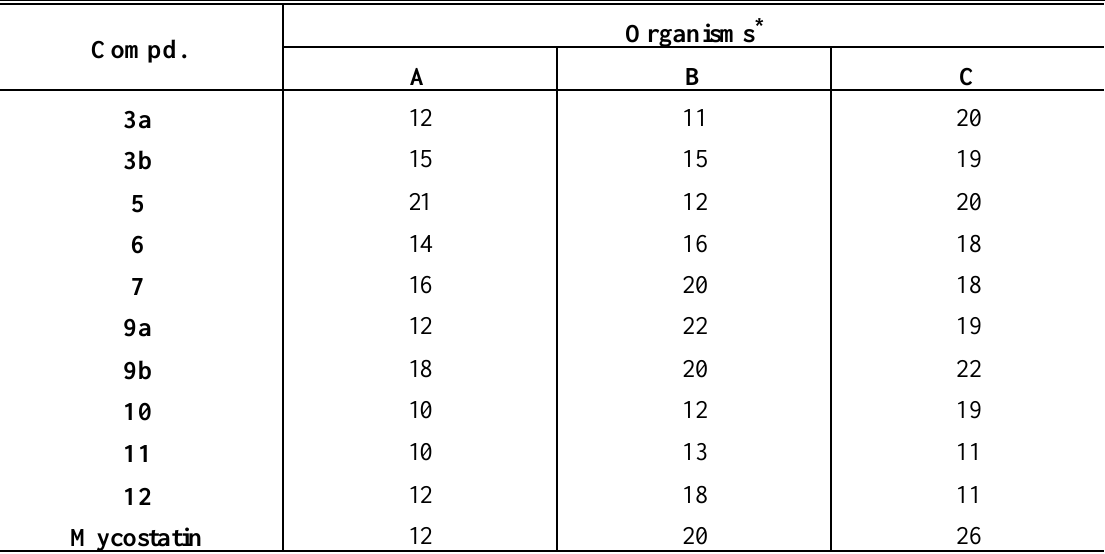
Table 2. Antifungal activity of the prepared